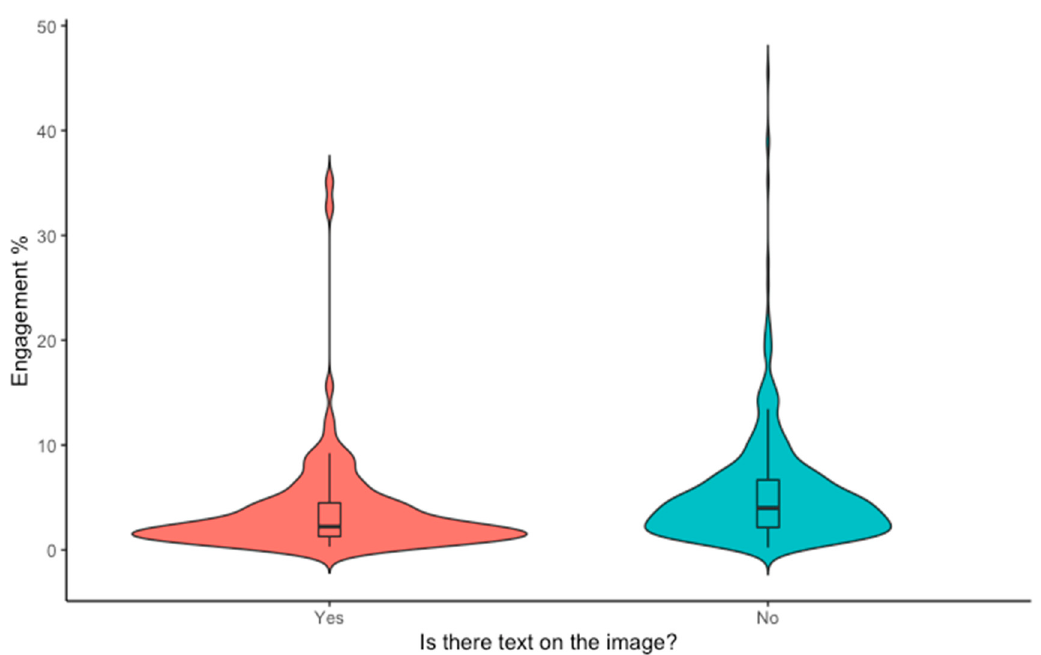
Figure 2. Violin plot with mean and interquartile range (IQR) showing the relationship between text on an image and viewer engagement (%) for Australian wildlife images posted to Instagram by conservation organisations from 1 January 2020–1 August 2021. Engagement is calculated as the number of likes an image received divided by the account follower count.